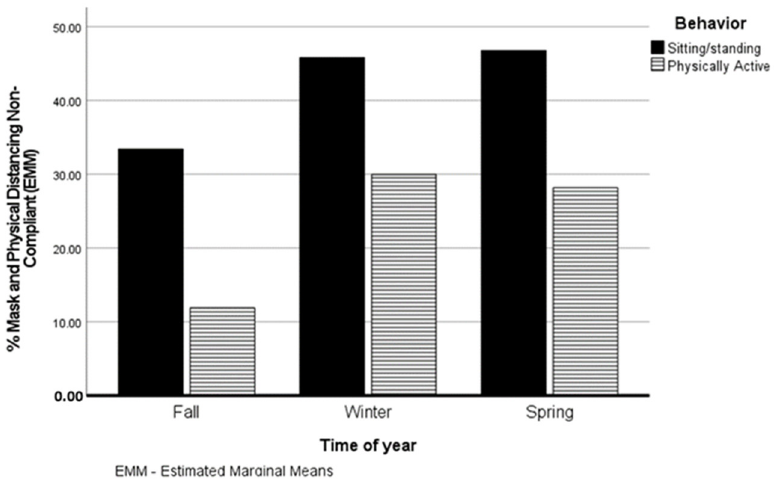
Figure 1. Percentages of non-physically active and physically active individuals per study week non-compliant with the recommendation for each of the three seasons.